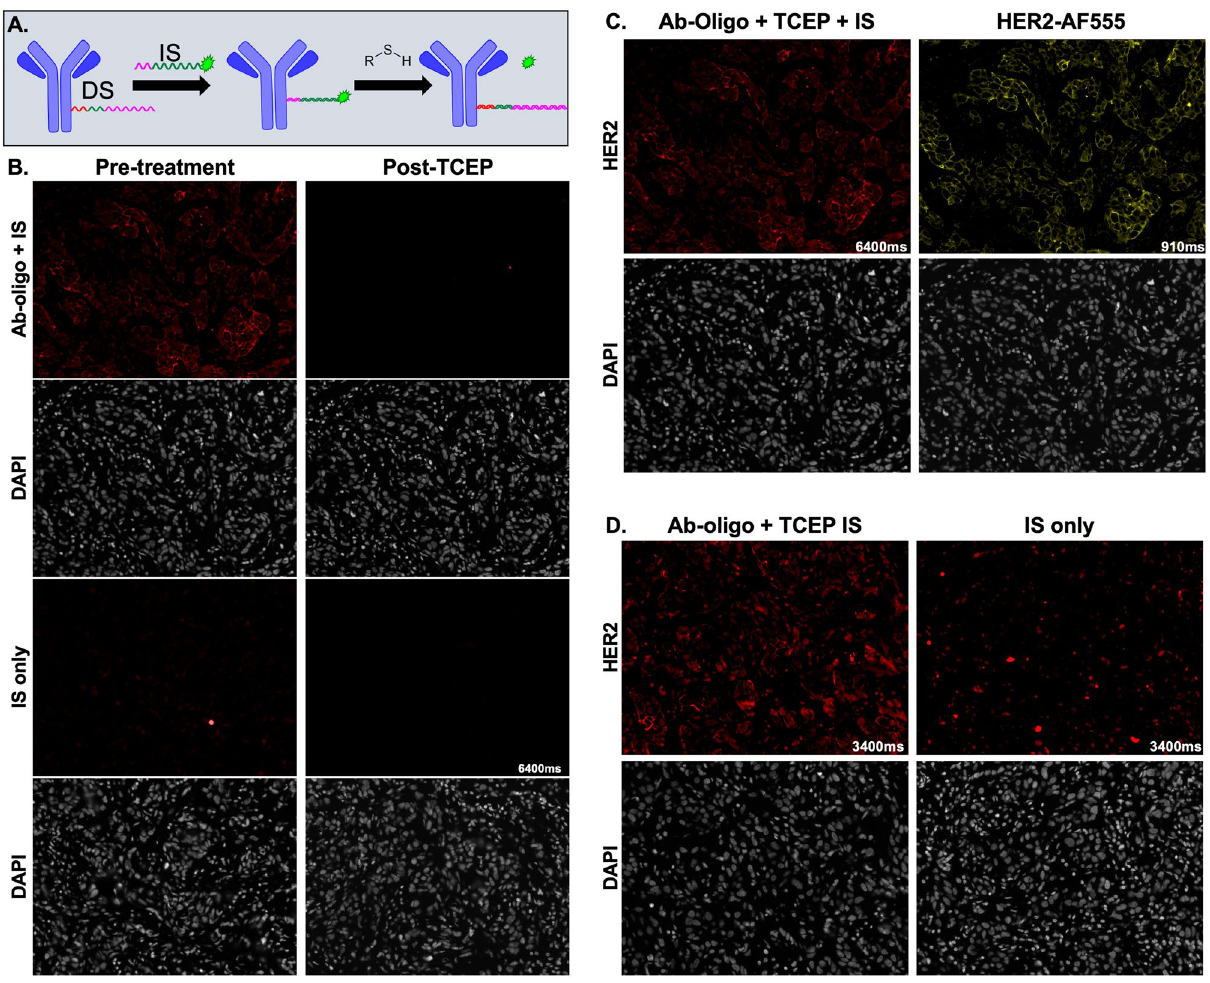
Figure 7. TCEP disulfide cleavage for signal removal. ( A ) Ab-oligo conjugates were incubated with a fluorophore-labeled IS modified with a disulfide adjacent to the fluorophore. Incubation with TCEP cleaved the disulfide, releasing the fluorophore, which could be readily washed away for signal removal. ( B ) Tissues stained with the HER2 Ab-oligo conjugate and disulfide modified IS saw complete signal removal after TCEP incubation. ( C ) After HER2 Ab-oligo signal removal, the tissue was stained with HER2 directly labeled with AF555 and the same FOV imaged to confirm preserved tissue antigenicity. ( D ) Increased background was observed in subsequent tissues stained with the HER2 Ab-oligo conjugate and disulfide modified the PCL IS groups, and remained in the IS group without a PCL, showing the specificity of this signal removal method (Fig. 8C). Optimized Ab-oligo cyCIF multiplexed imaging. A nine-color image was generated of HCC827 xen- ograft tissue where Ab-oligo conjugates labeling E-Cad, Ki-67, phospho-AKT (pAKT), cytokeratin 8 (CK8), cleaved caspase-3 (CC3), phospho-MEK (pMEK), epidermal growth factor receptor (EGFR), phosphoinositide 3-kinase (PI3K) and AKT were applied (Fig. 8D). Rounds of imaging were performed by applying sets of IS modified with PCLs and fluorophores. Tissue scanning was performed in each staining round for visualization of the specimen with one representative field of view displayed where individual cell staining patterns were visualized. Marker specific staining pattern was seen for all imaged antibodies. Due to the relative homogeneity of xenografts, there was overlap in the staining pattern for some of the markers especially the EGFR signaling pathway proteins EGFR, AKT, pAKT, PI3K and pMEK. E-Cad and CK8, commonly expressed in epithelial cells, provided a spatial map for the HCC827 cells. Further, Ki-67 and CC3, marking proliferating and apoptotic cells, respectively, were expressed in distinct cells where DAPI staining provided this spatial context. Importantly, complete signal removal was achieved after 15 min of UV treatment between rounds of imaging eliminating any potential cross-talk between markers imaged in different rounds.